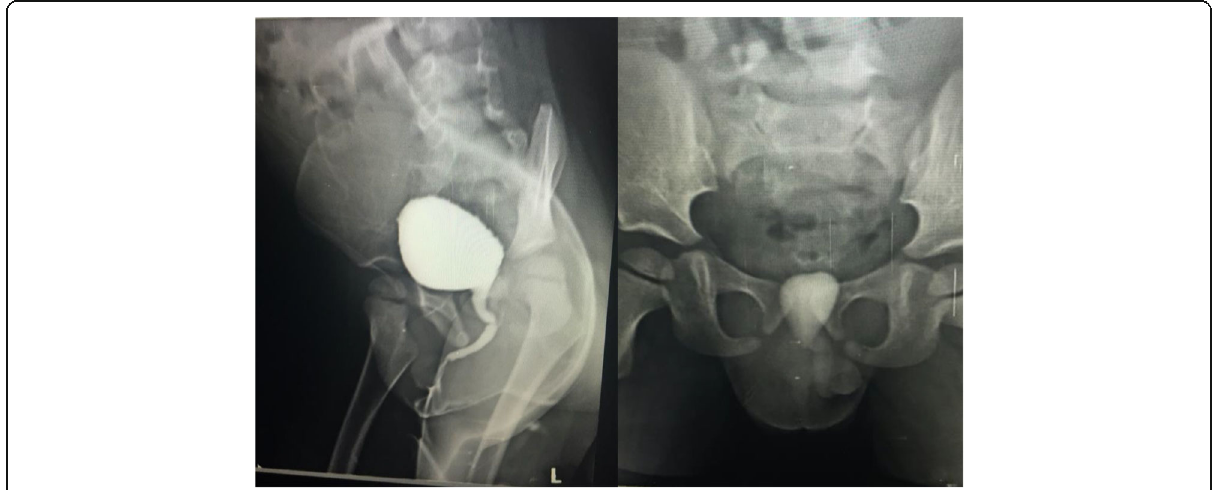
Fig. 4 Micturating cystourethrogram (MCUG) showing the prostatic utricle (PU) and retained dye in the pouch in post void